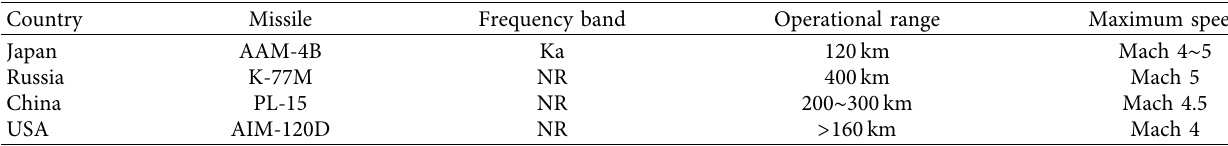
Table 4: Main parameters of diferent missile-borne